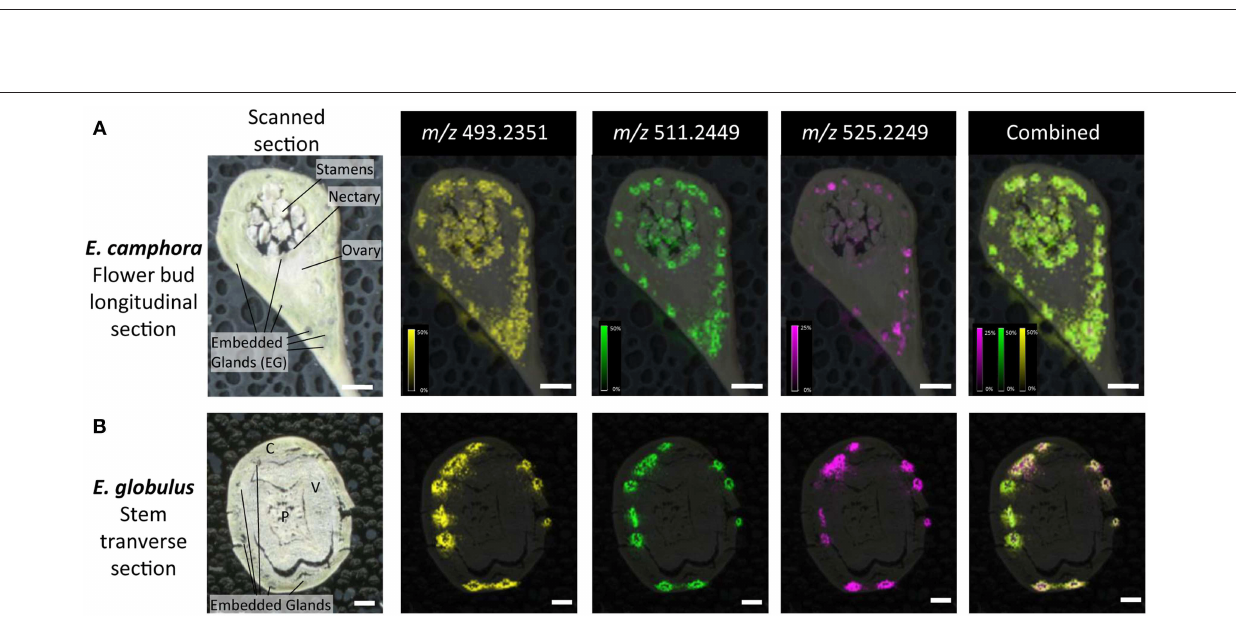
Frontiers in Plant Science |